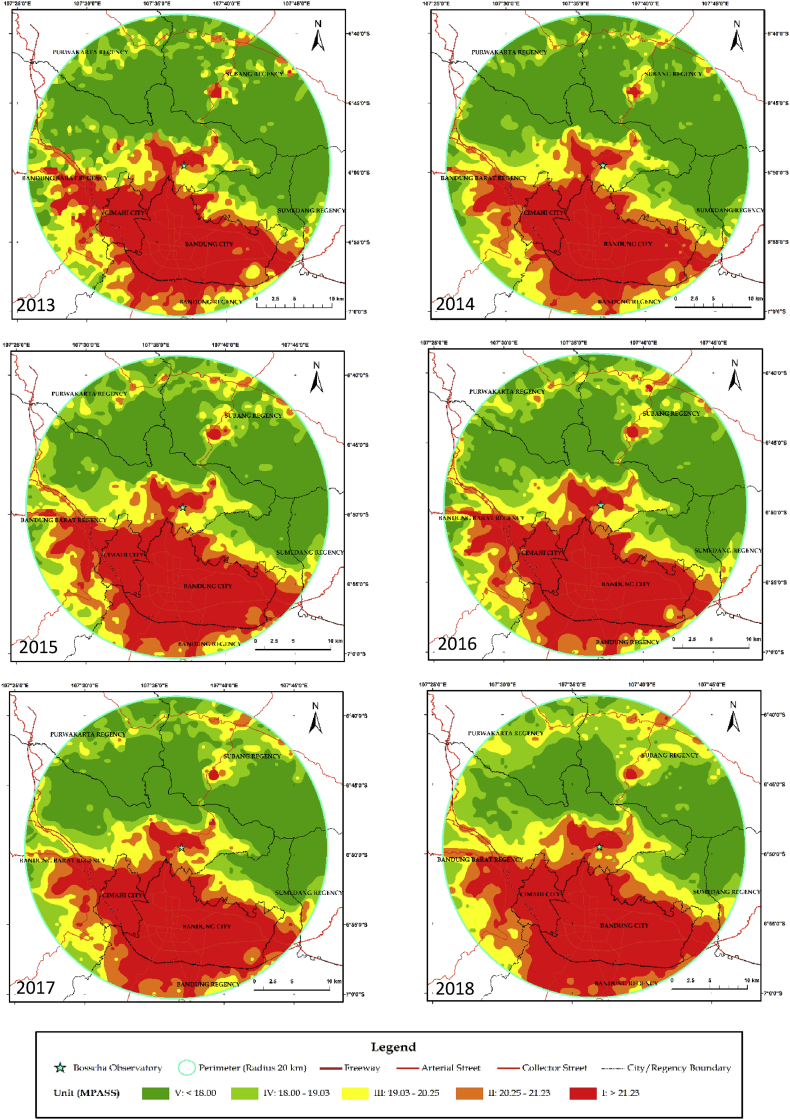
Sky-brightness distribution within a 20-km radius centered at the BO (star symbol) for 2013 to 2018.